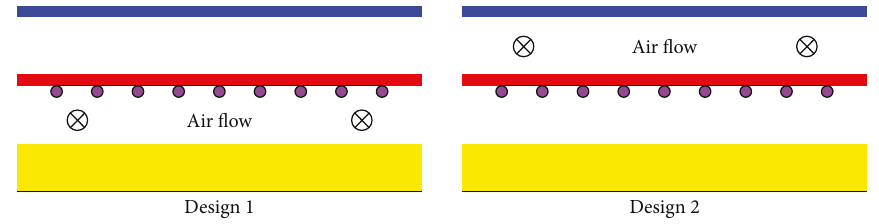
Figure 1: Solar DAWC designs considered in the Type 207